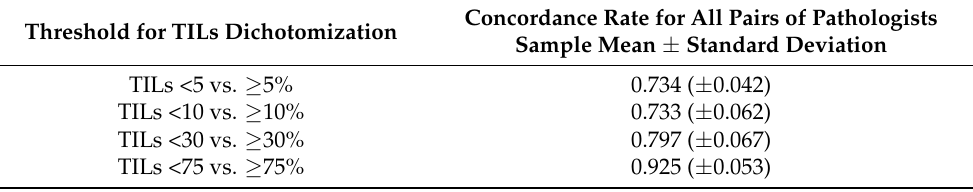
Table 5. Exploratory analysis of four different thresholds for TILs dichotomization and their influence on the concordance among all ten participating pathologists.